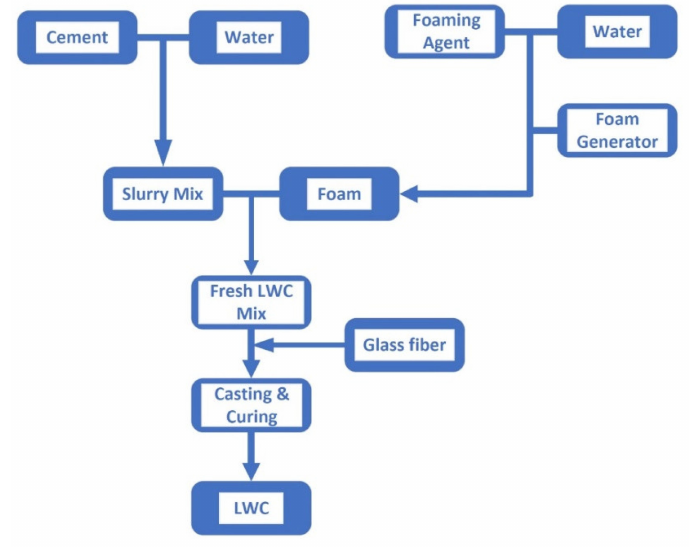
Figure 1. The manufacturing process of light weight concrete